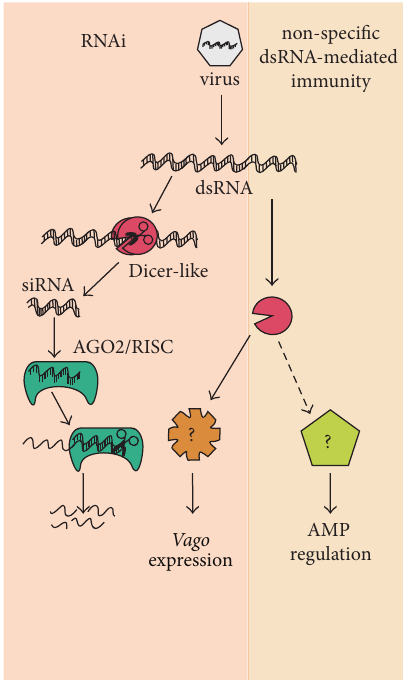
Figure 1: RNAi and non-sequence-specific dsRNA mediated